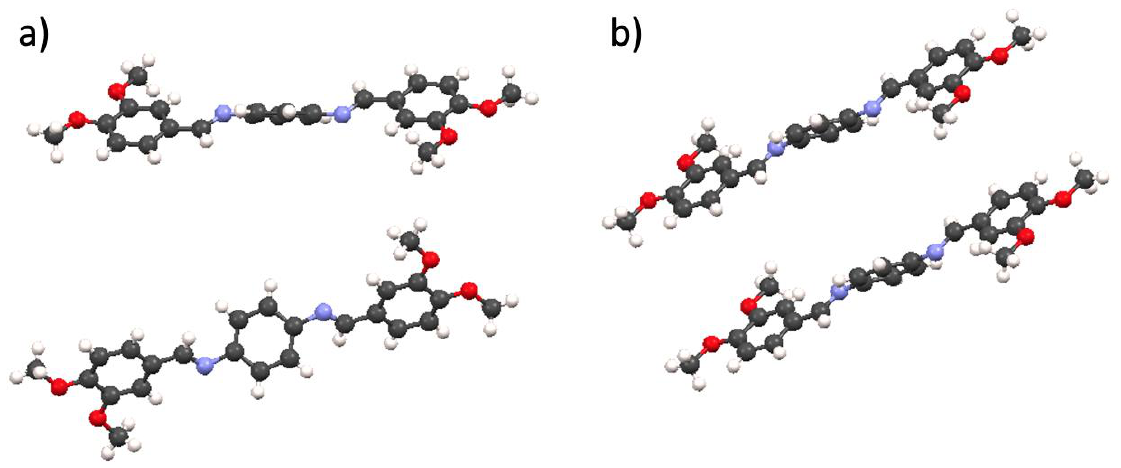
Figure 5. XRD structure of M1a . ( a ) face and side view. ( b ) packing represented with 2 molecules in the lattice.